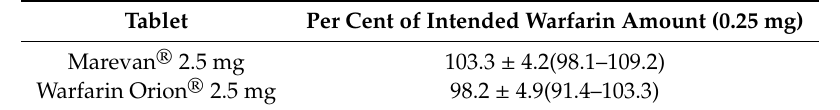
Table 3. Extracting a fraction: Suspending a warfarin tablet in 10 mL water and extracting a 1 mL fraction 1 . Per cent of intended value ± sd (low–high) ( n = 6), is given.